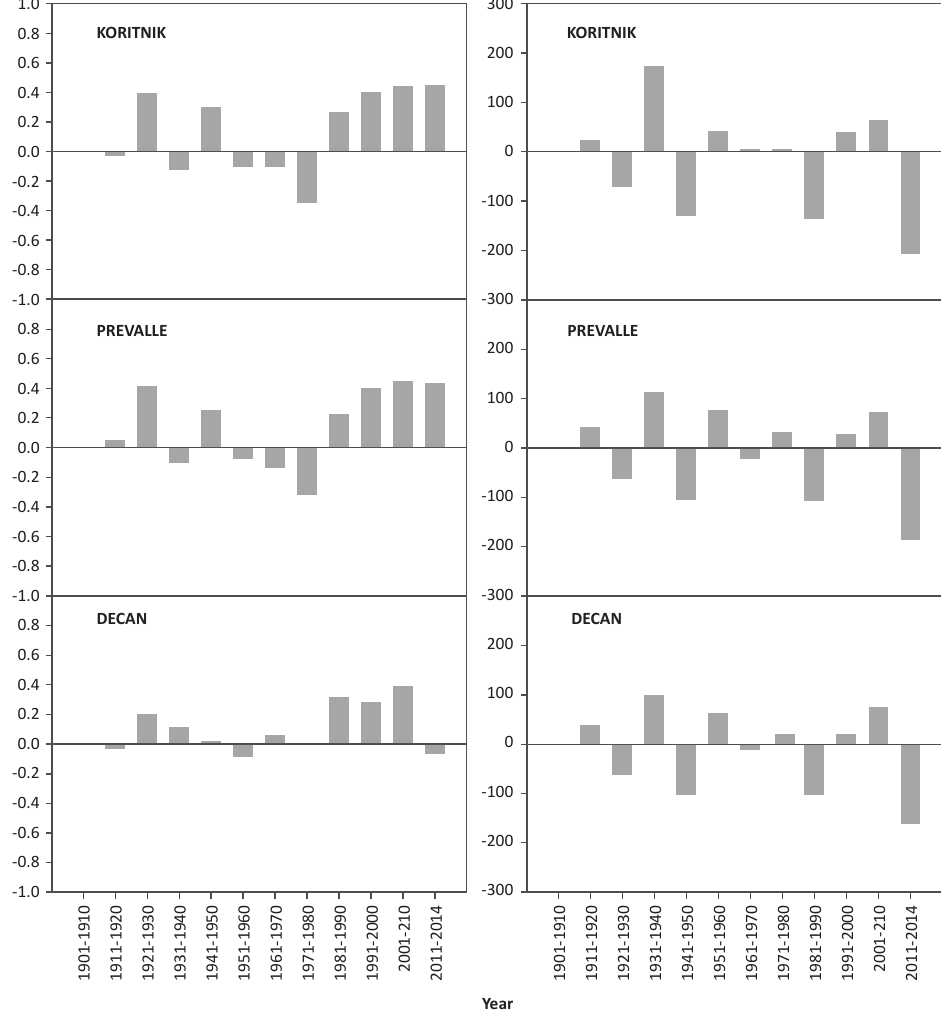
figURe 5. Decennial successive differences between mean annual temperatures and mean annual sum of precipitation for the period 1901-2014 (including the period 1951-2013 used as reference in bootstrap correlation